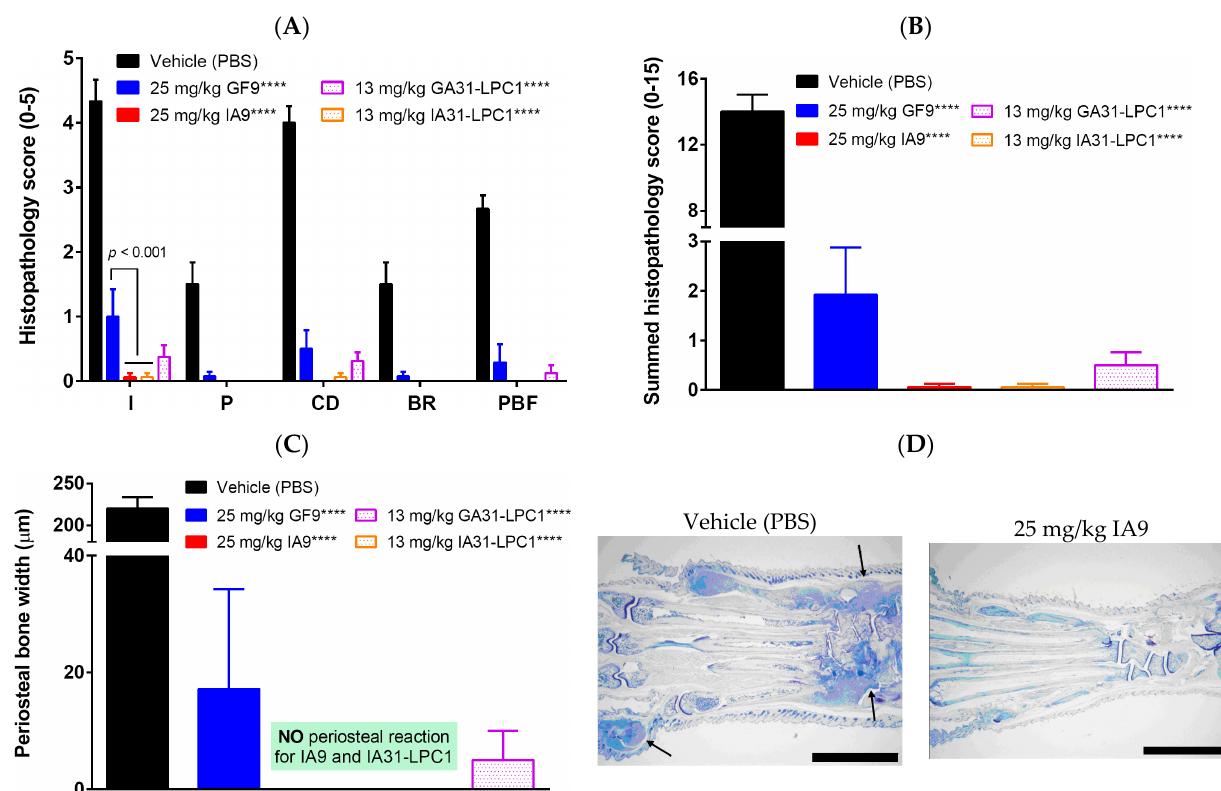
Figure 3. Effect of therapeutic treatment with free and LPC-bound IA9 and GF9 sequences on histopathological scores of inflammation (I), pannus (P), cartilage damage (CD), bone resorption (BR), and periosteal new bone formation (PBF) ( A ), summed histopathological score ( B ) and periosteal bone width ( C ). No periosteal reaction was observed in IA9- and IA31-LPC1-treated mice ( C ). Photomicrographs of hind paws of vehicle- and IA9-treated arthritic mice stained with toluidine blue (animals with the approximate mean summed paw score for the group were selected) ( D ). Arrows identify representative affected joints. The scale bars at the bottom right of the images indicate 5 mm. Data are shown as mean ± SEM ( n = 8). ****, p < 0.0001 versus vehicle.